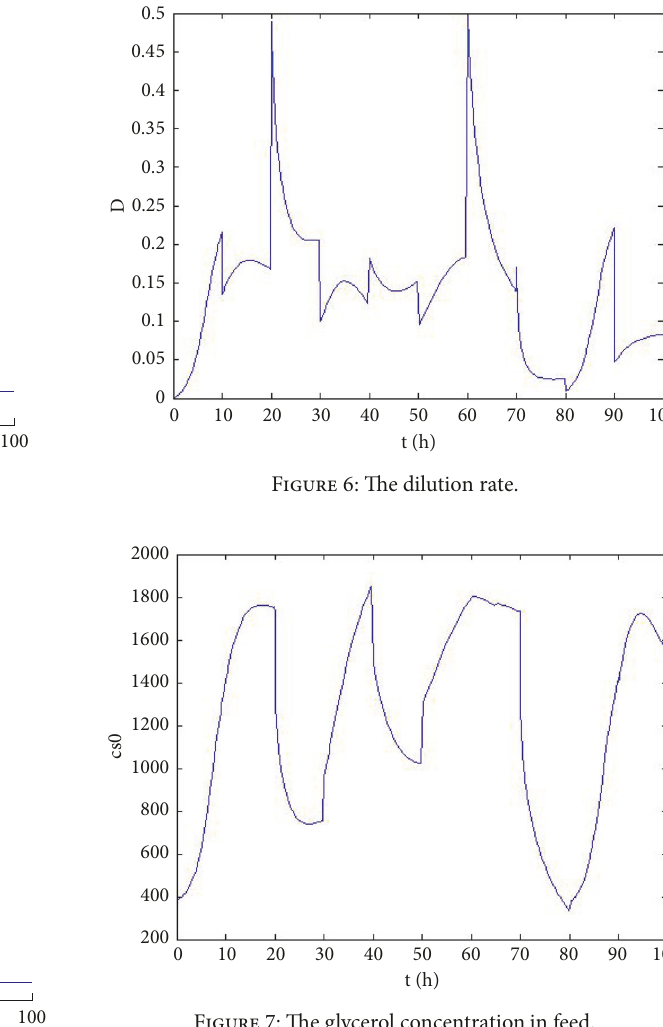
Figure 7: The glycerol concentration in